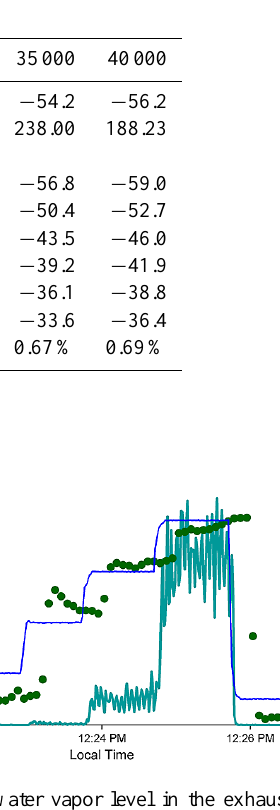
Fig. 3. Effect of water vapor level in the exhaust on ice particle formation: real-time measurement of OPC ice particle concentra- tion (turquoise) and particle optical extinction coefficient (green) at 61cm downstream of the exhaust nozzle when the exhaust water vapor level (blue) was varied between 0–4% in molar fraction in the exhaust. Note that each water level was held constant for ap- proximately 1min in order for the ice concentrations to